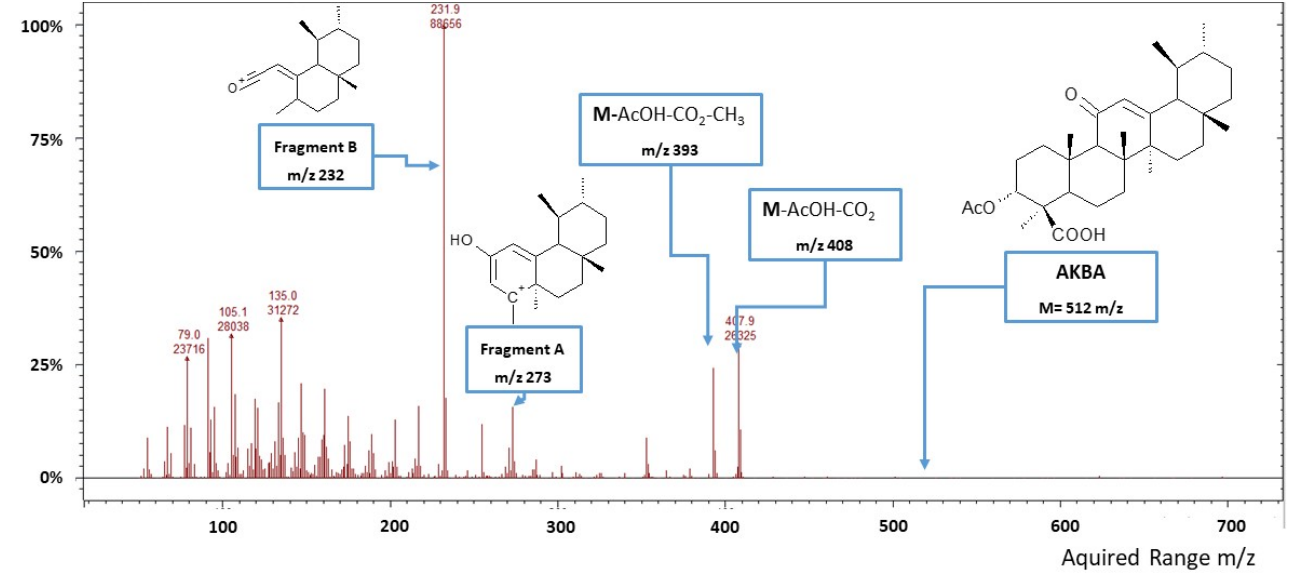
Figure 1. Mass spectrum (full scan mode) of 3-O-acetyl-11-keto- β -boswellic acid (AKBA).